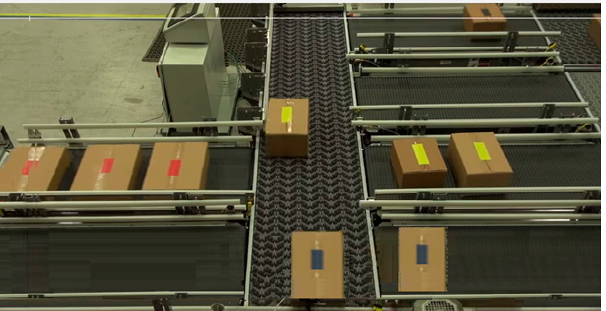
Figure 2. The example of an AMHS (Automated Material Handling System) with ARB (Activated Roller Belt) conveyor.